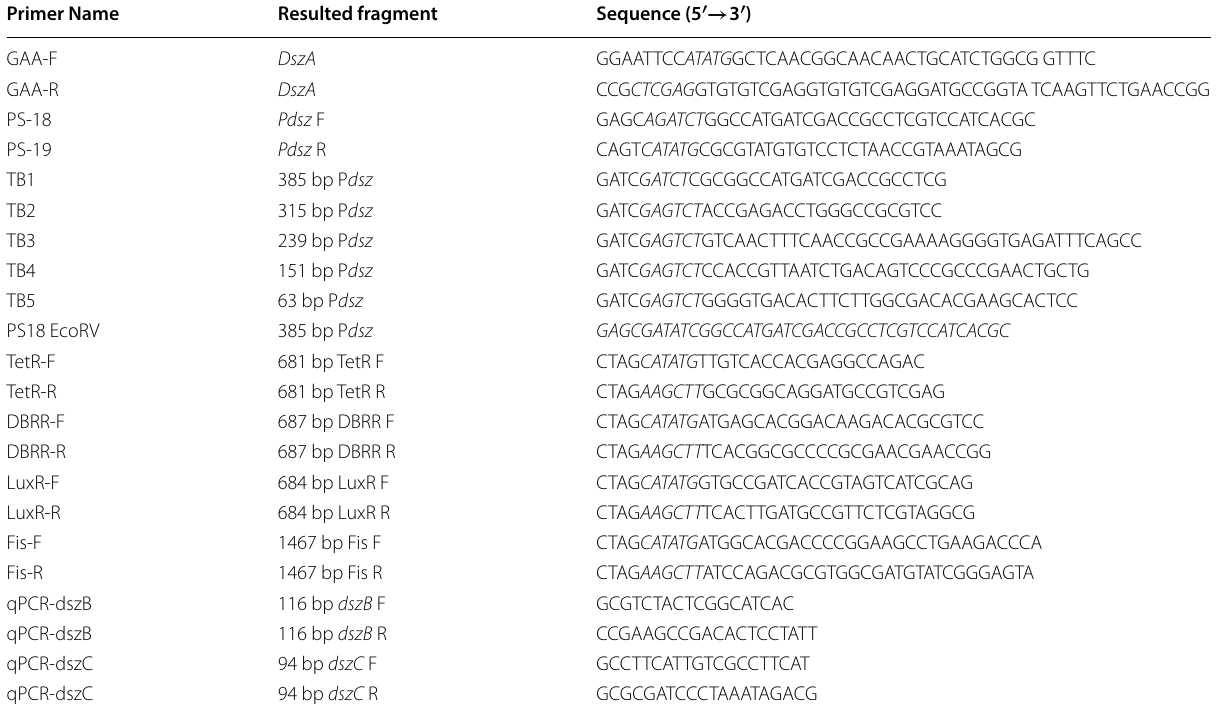
Table 2 List of primers used in the study (restriction sites italicized) Primer